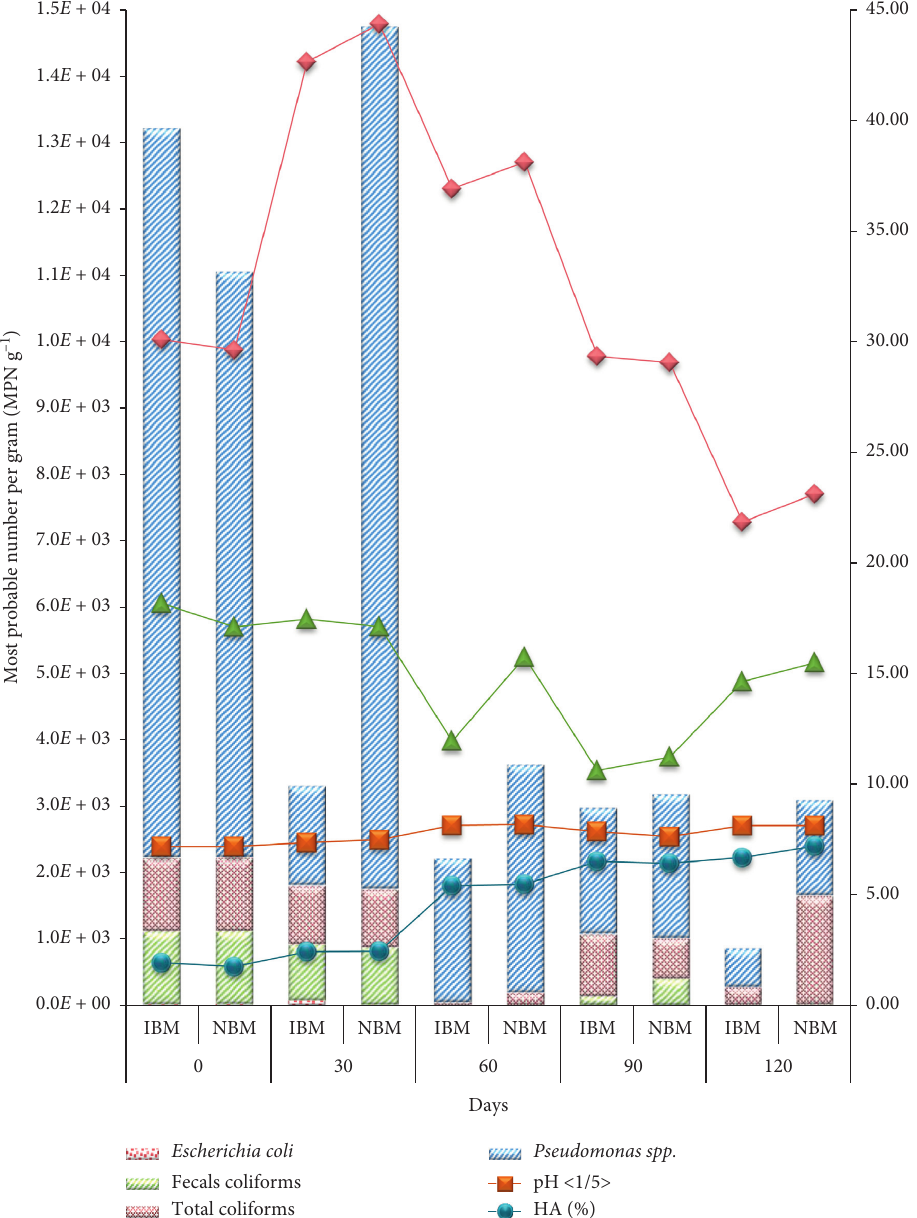
Figure 6: Microbiological variables counted as most likely number per gram (NMP · g − 1 ) during composting of cow manure and tree litter in piles inoculated with beneficial microorganisms (IBM) and in noninoculated piles (NBM) and physicochemical variables (HA, pH, temperature, and C/N